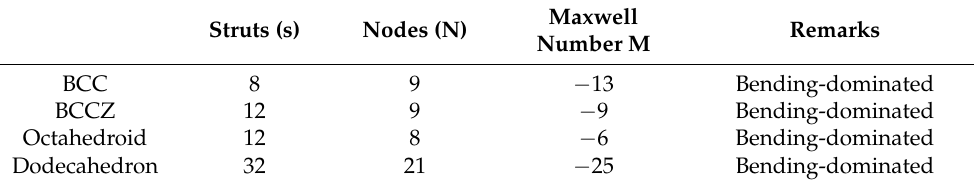
Table 4. Maxwell’s stability criteria check.